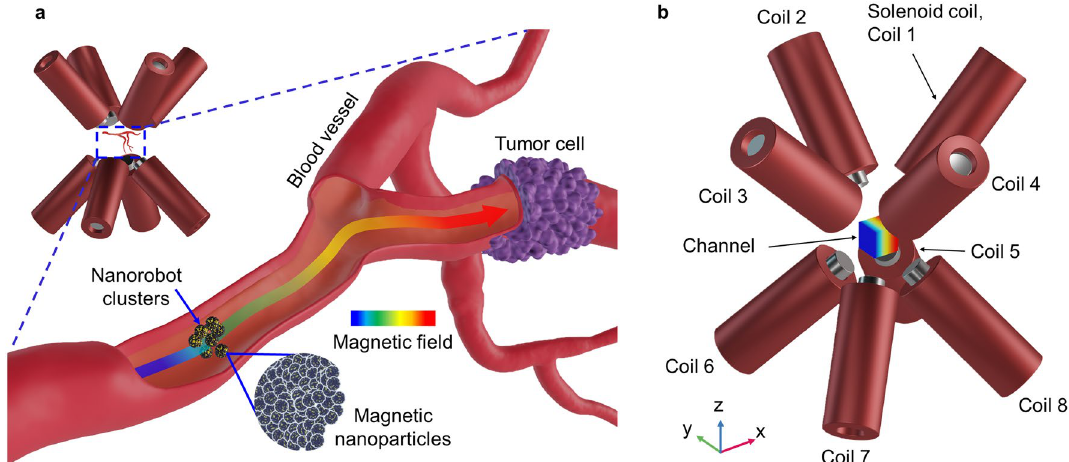
Figure 1. Schematic image of the magnetic drug delivery system and the electromagnetic actuation system. ( a ) Schematic illustration of the magnetic drug delivery system. The nanorobot cluster is pulled to the target due to the magnetic field gradient. ( b ) Schematic illustration of the electromagnetic actuation system with labelled coils. The electromagnetic actuation system includes coils, cores, and a